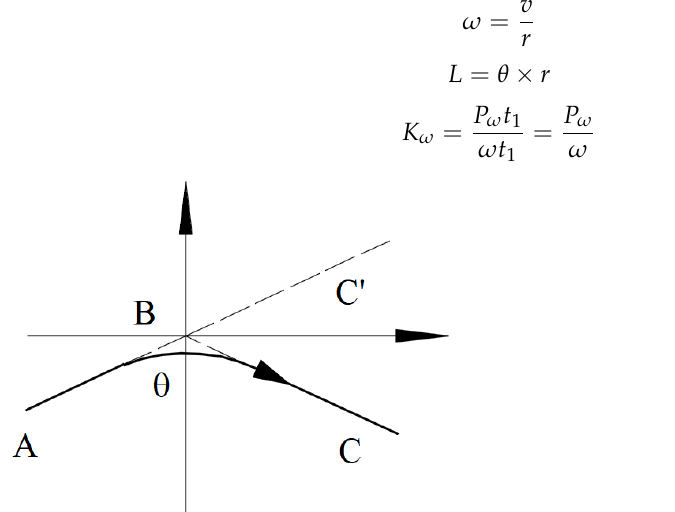
( b ) Figure 3. Force analysis of motion for UAV: ( a ) force of forward movement; ( b ) force of rise. G is the force of gravity received by the UAV as it moves. Gravitational acceleration 9.8